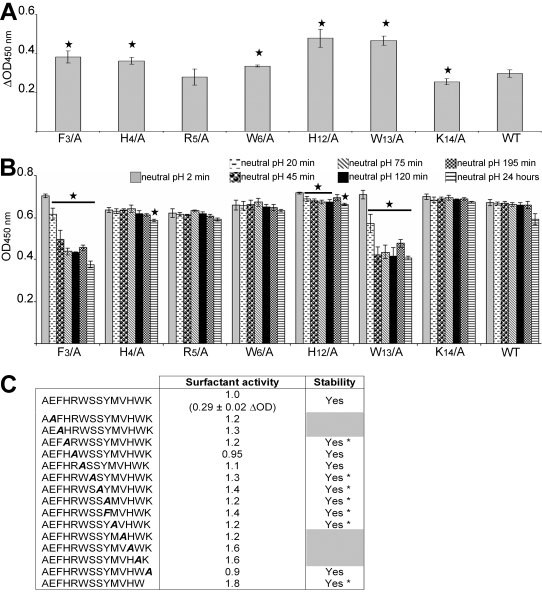
Surfactant properties of AChE586-599 and AChE586-599 mutants.Surface tension was measured before and after neutralization (1M NaH2PO4, pH 7.2). (A) Representative surfactant activity of the AChE586-599 mutants (50 µM). ΔOD calculations were as described in Methods. A black star signifies p<0.035 when compared to AChE586-599. (B) Temporal pattern of the surfactant properties for AChE586-599 and AChE586-599 mutants. The peptides shown are representatives of the different surfactant properties observed. A black star signifies p<0.05 when compared to the same peptide after 2 min at neutral pH. (C) Surfactant properties for AChE586-599 and all AChE586-599 mutants (50 µM). The properties are divided into 2 categories: surfactant activity dependent on pH (depicted by subtracting the value at acidic pH to the value at neutral pH after 2 min) and stability of the surfactant activity (indicated by stability or decay of the OD signal). The mutation within AChE586-599 is indicated in bold and italics. The peptides with unstable surfactant activity are indicated by grey boxes. ‘*’ indicates peptides which activity remains stable over the time course, albeit one time point. The activity for the mutant peptides is shown as fold ratio of AChE586-599 activity (e.g. ‘1’ represents equal value to AChE586-599).